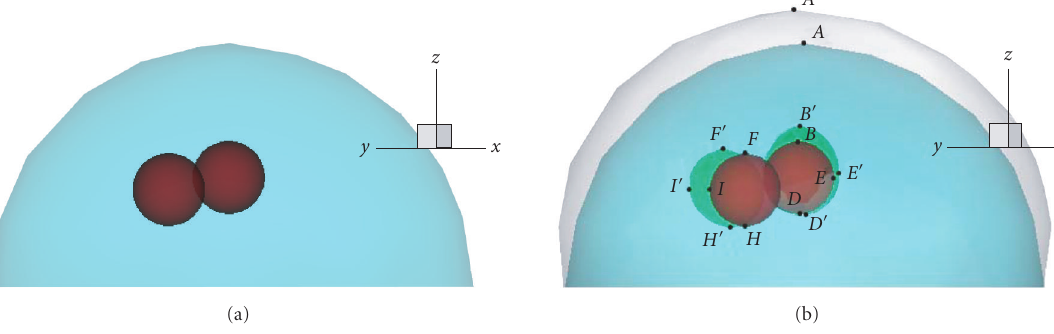
Figure 6: Mammography projections for Phantom II under Loading 2. Projections are made along direction 2. (a) Undeformed projection; (b) deformed projection overlaps on undeformed projection. In the projections, vertexes A ∼ I in undeformed projection move to A (cid:3) ∼ I (cid:3) in deformed projection, respectively. Table 1: Initial estimate and reconstructed results for elasto-mammography. Tissue Tumor